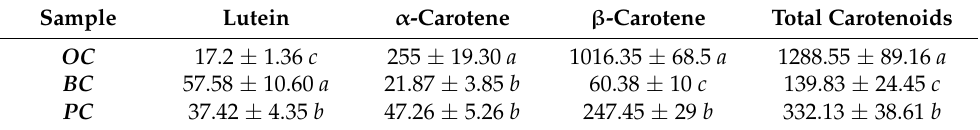
Table 3. Carotenoid (lutein, α -carotene, β -carotene and total) contents in orange carrot (OC), black carrot (BC) and purple “Polignano” carrot (PC) extracts, as µ g. g − 1 dry weight